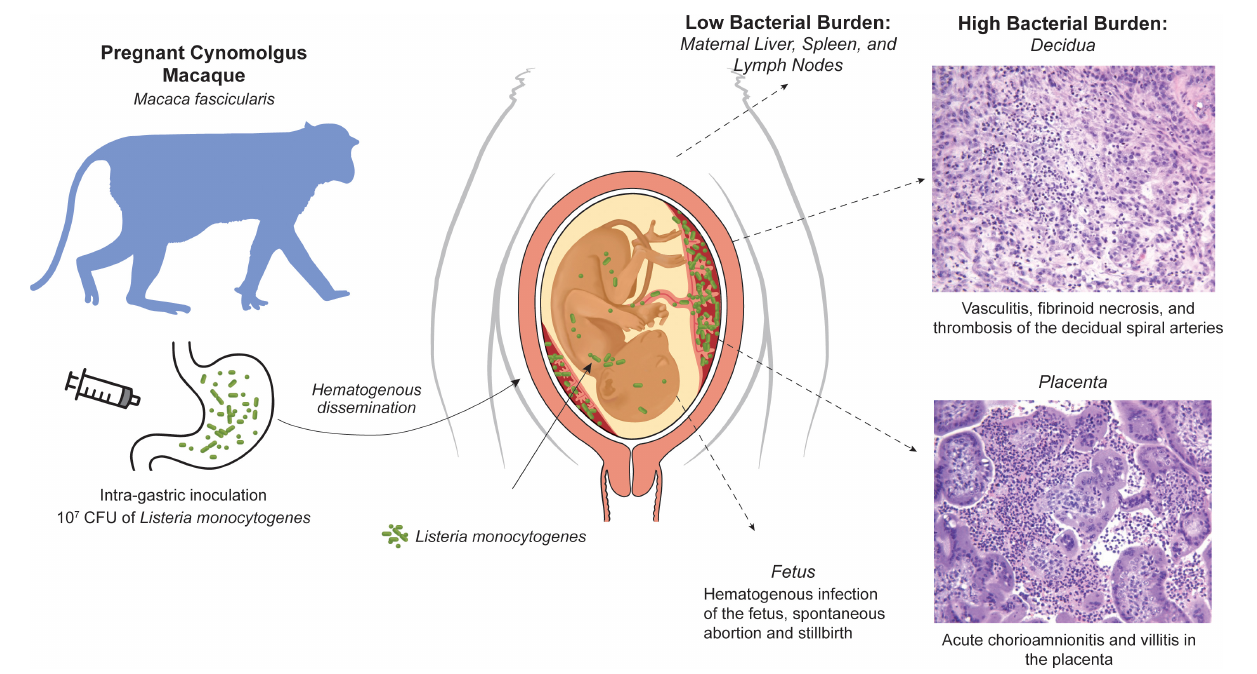
FIGURE 3 | NHP cynomolgus macaque ( M. fascicularis ) model of listeriosis in pregnancy. Intragastric inoculation of L. monocytogenes in the first trimester results in bacteremia that is associated with a modest bacterial burden in classic Listeria target organs (liver, spleen, lymph nodes), but profound infection and histopathology at the maternal-fetal interface, fetal infection, and fetal